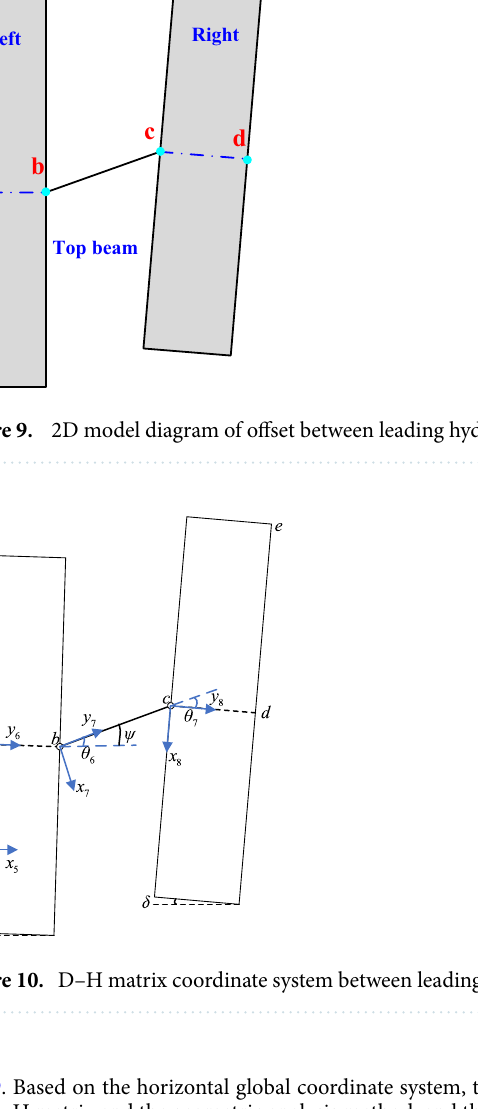
Fig. 9. Based on the horizontal global coordinate system, the kinematics equation is established by combining the D–H matrix and the geometric analysis method, and the pose parameters of key nodes are solved. A D–H matrix coordinate system is established, as shown in Fig. 10. The hinge joint of each component is selected as the origin coordinate, and the reference coordinate system { o 5 } takes point o as the origin of the coordinate, and its y 5 axis coincides with oa , which is vertically upward, and the x 5 axis is perpendicular to oa . Coordinate system { o 6 } of the left advanced hydraulic support takes point α as the origin of the coordinate system, and its x 6 axis coincides with the base oa , vertically downward, and the y 6 axis is perpendicular to oa . Balance cylinder coordinate system { o 7 } takes point b as coordinate origin, y 7 axis coincides with balance cylinder bc , and the x 7 axis is perpendicular to bc . The coordinate system { o 8 } of the right advanced hydraulic support is based on point c , where the y 8 axis coincides with the base cd, and the x 8 axis is perpendicular to the cd . Based on the derivation of the coordinate transformation matrix in the previous section, coordinate system { o 6 } to { o 5 } can be regarded as the coordinate system { o 6 } rotates along the z axis θ 5 angle and translating l oa along the negative direction of the y axis of the transformed coordinate system to obtain the coordinate system { o 5 } .